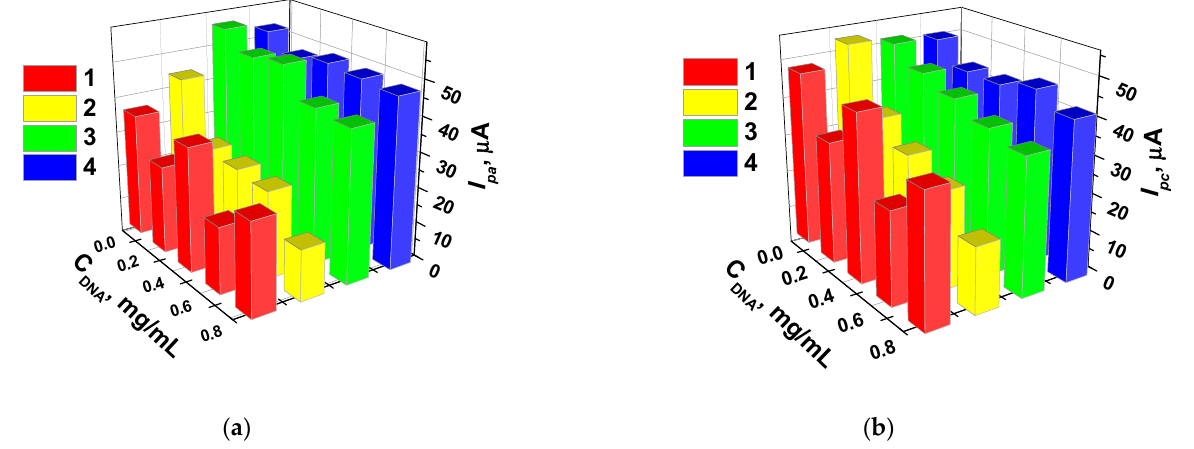
Figure 3. ( a ) The dependence of the anodic ( a ) and cathodic ( b ) peak currents of [Fe(CN) 6 ] 3 − ion on the content of the surface layer: 1—GCE/CB, 50 μ M TC; 2—GCE/CB, 5 μ M TC; 3—GCE, 50 μ M TC; 4—GCE, 5 μ M TC.